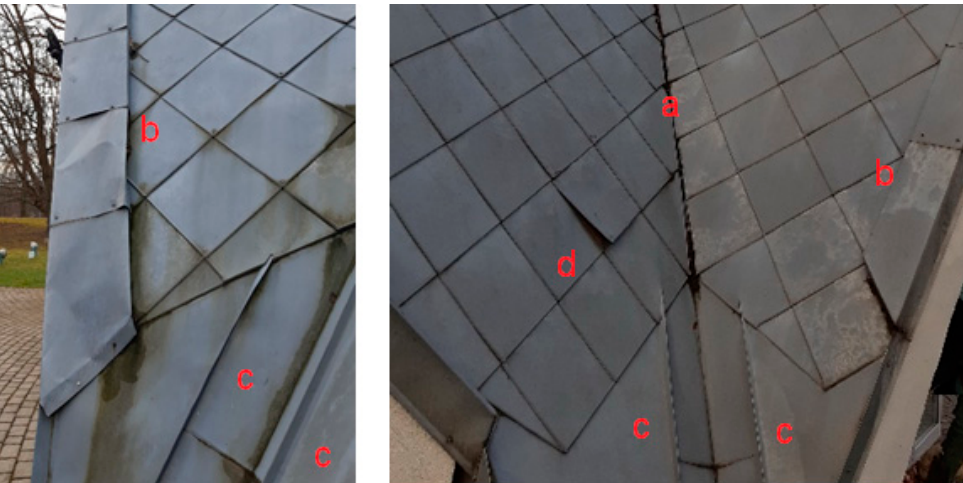
Figure 6. Configurations of edges of the analysed shell: ( a ) single edge separating patches; ( b ) closely adjacent two edges; ( c ) closely adjacent four edges; ( d ) two edges with an undetermined connection—crack and displacement.